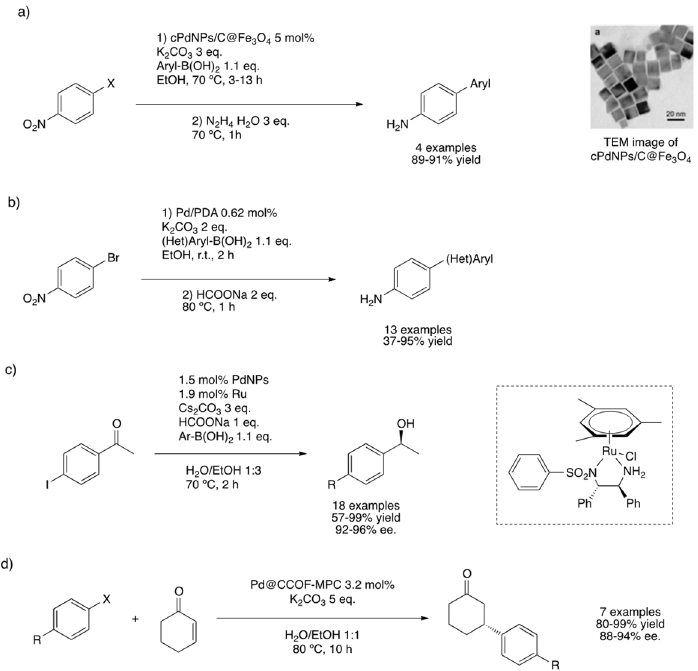
Figure 6. Sequential Suzuki–Miyaura cross-coupling coupled to reduction reactions over cubic PdNPs/C@Fe 3 O 4 ( a ) [73,74], Pd/PDA ( b ) [75] and dual Pd–Ru supported on SiO 2 NPs ( c ) [77]. Tandem asymmetric reductive Heck coupling over Pd@CCOF-MPC ( d ) [78]. Reproduced from [74] with permission from the American Chemical Society.